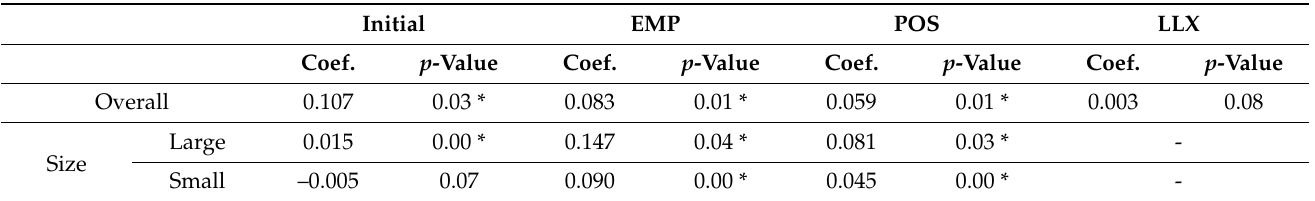
Table 3. Coefficients and significance of moderations for the LMX relationship and overall OCB depending on hospital size.